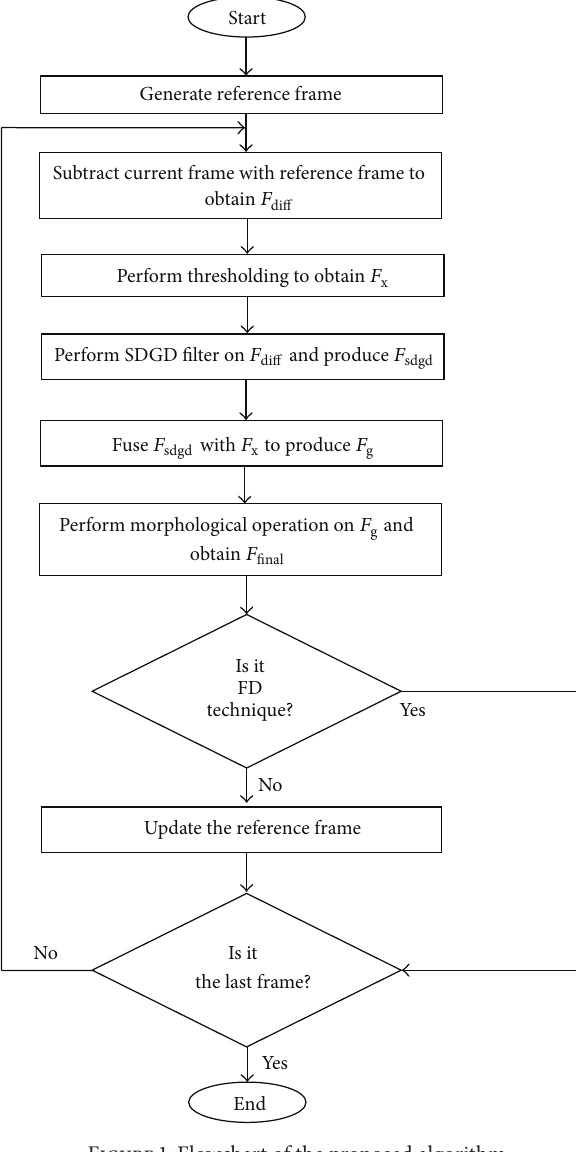
Figure 1: Flowchart of the proposed